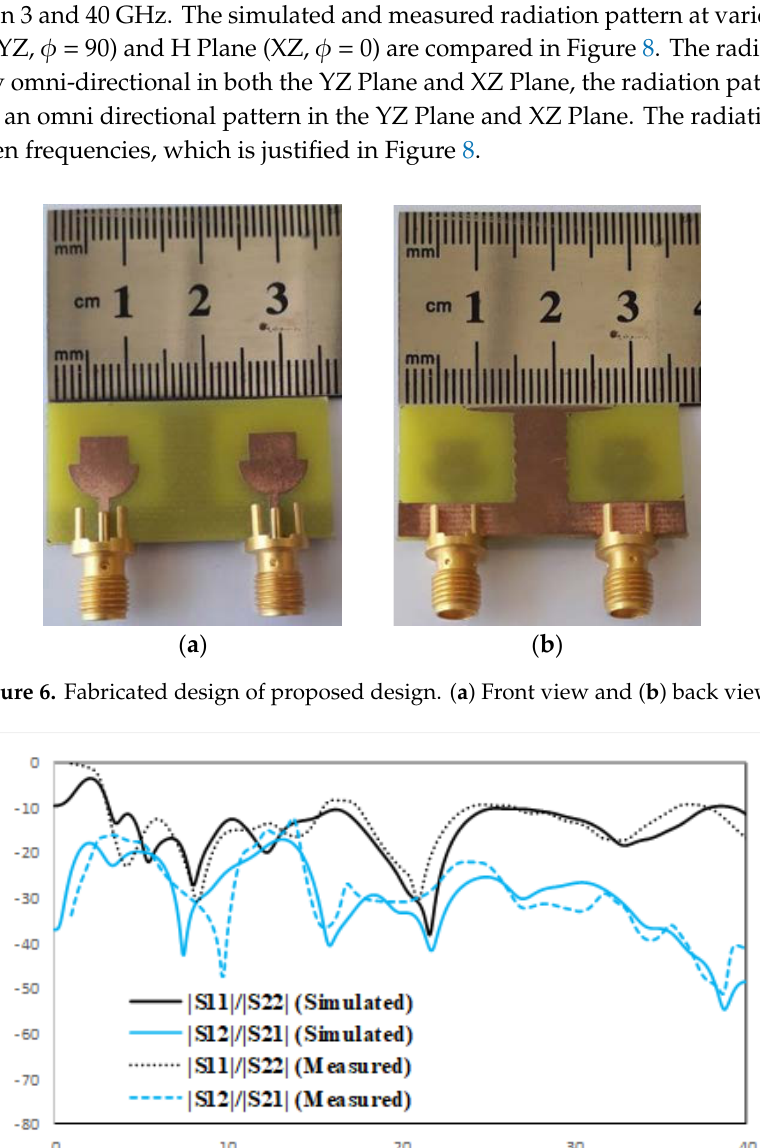
parameters of proposed MIMO antenna. | 𝑆𝑆 |